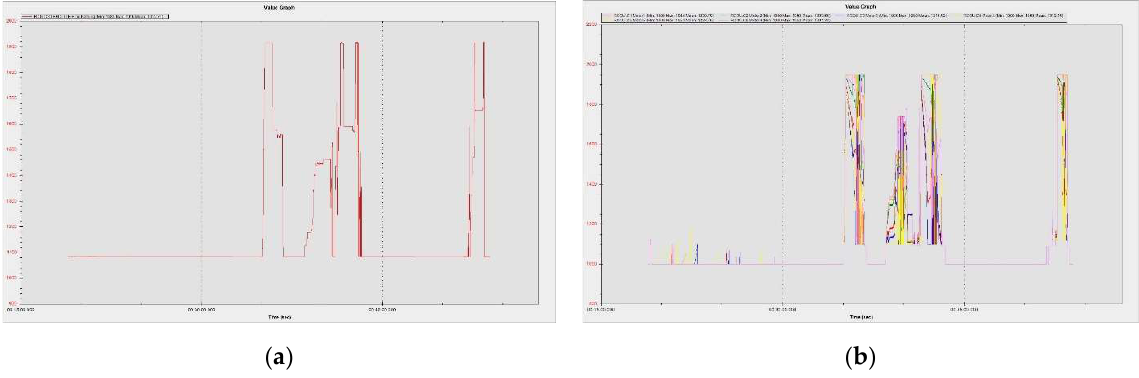
Figure 27. Tests performed on the motors without propellers. ( a ) Speed command given by the operator; ( b ) Engine response to the operator command.